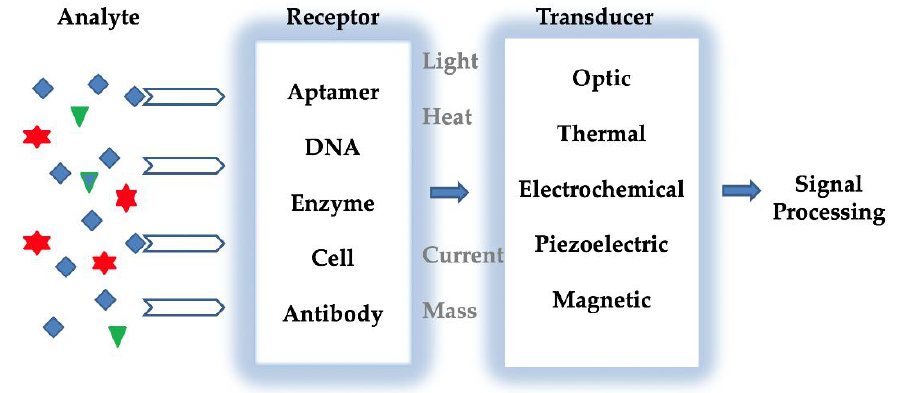
Figure 1. Typical detection principle of a biosensor.